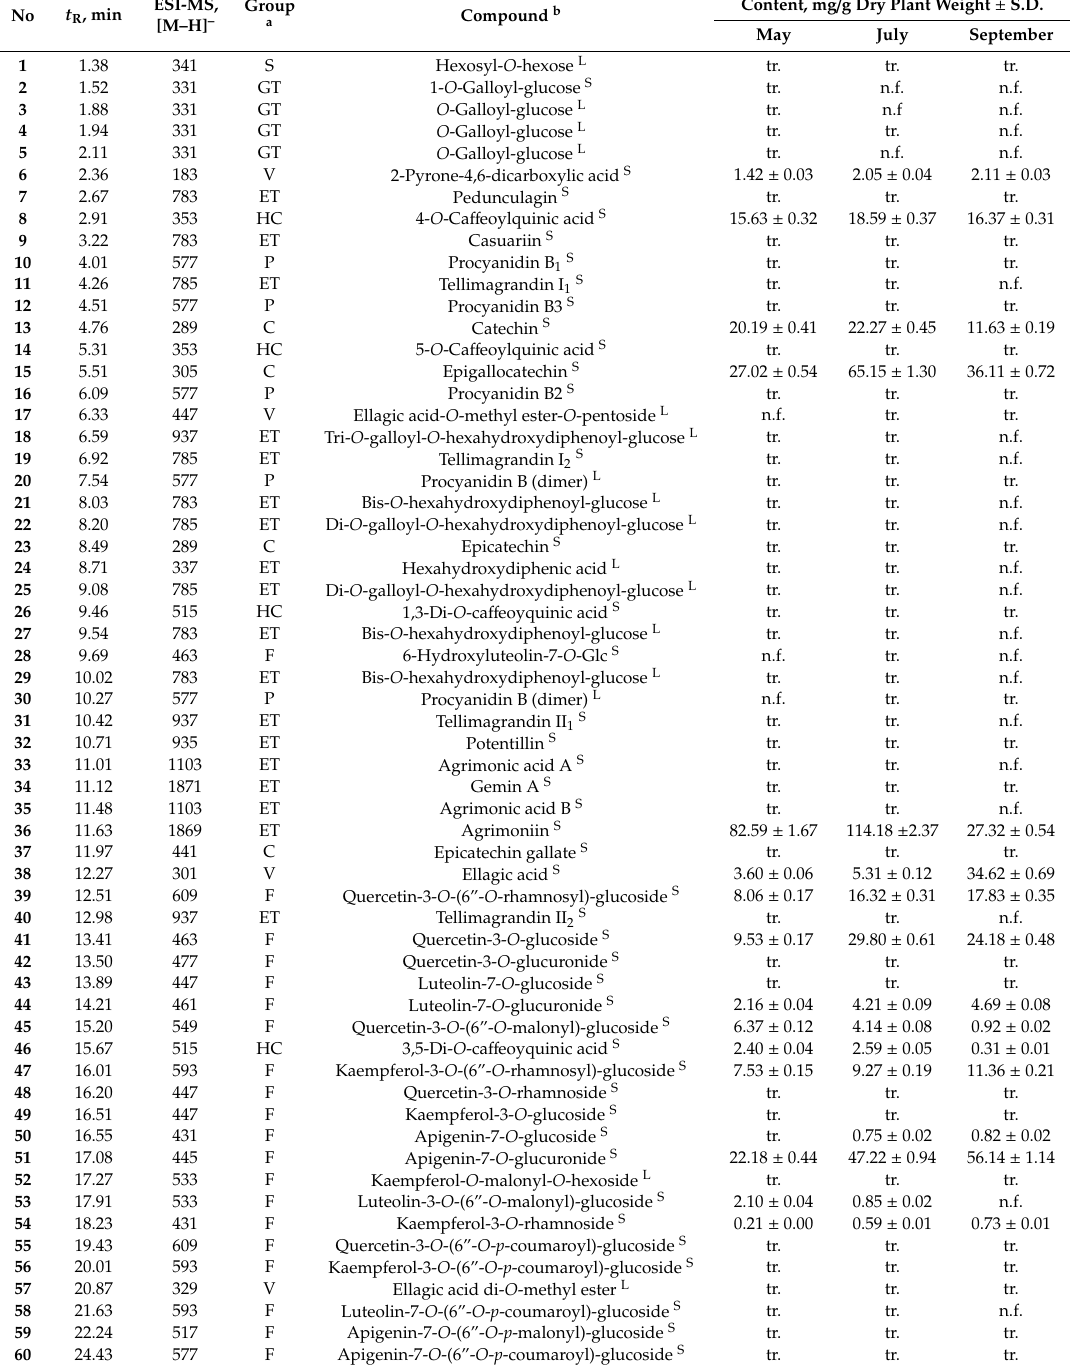
Table 3. Chromatographic ( t R ), mass-spectrometric data (ESI-MS), and seasonal presence / content of compounds 1 – 60 found in the Agrimonia asiatica